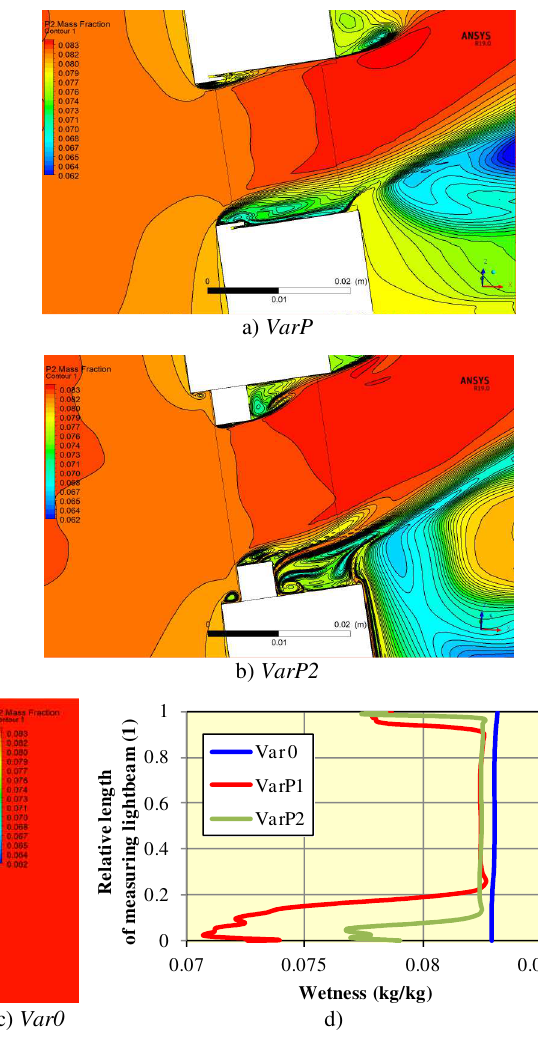
Fig. 6 . Results of the CFD simulations – steam wetness, a), b), c) Contours of steam wetness on the cross-section of the domain PROBE, d) Distribution of average steam wetness along the measuring beam.